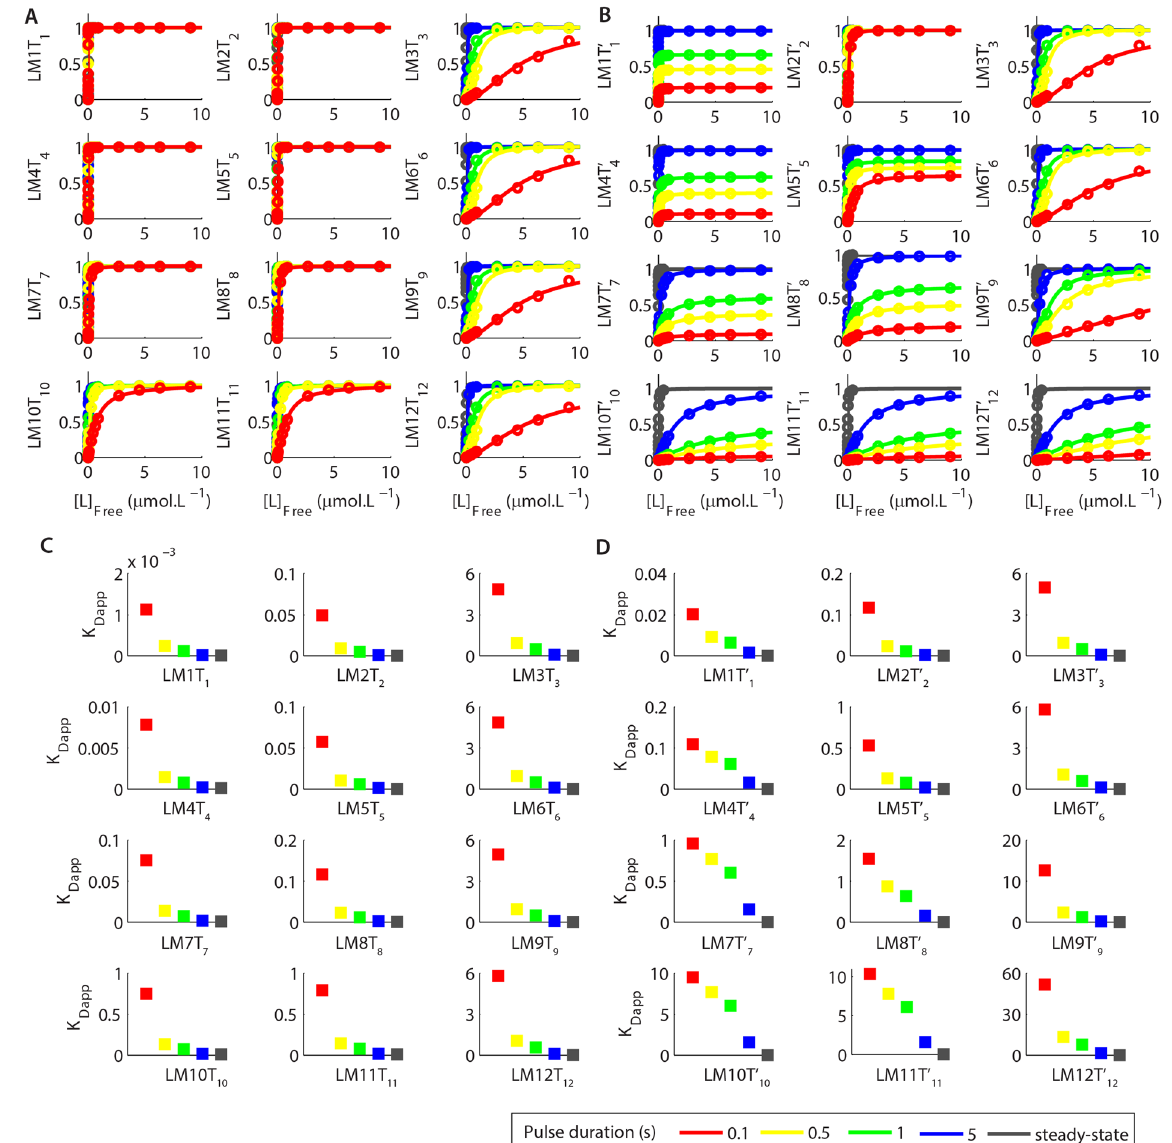
Figure 7. Detection and discrimination of dynamic signals by sequential reactions. ( A ) Dose-response curves of the complexes LM1T f1 -LM12T f12 as functions of [L] free with different durations. ( B ) Dose-response curves of the complexes LM1T ′ 1 -LM12T ′ 12 as functions of [L] free with different durations. ( A , B ) Values of K Dapp estimated for the activation of LM1T f1 -LM12T f12 ( C ) and LM1T ′ 1 -LM12T ′ 12 ( D ) for pulses of [L] free with different durations. The legend indicates the colour code used to represent durations of the pulses of [L] free